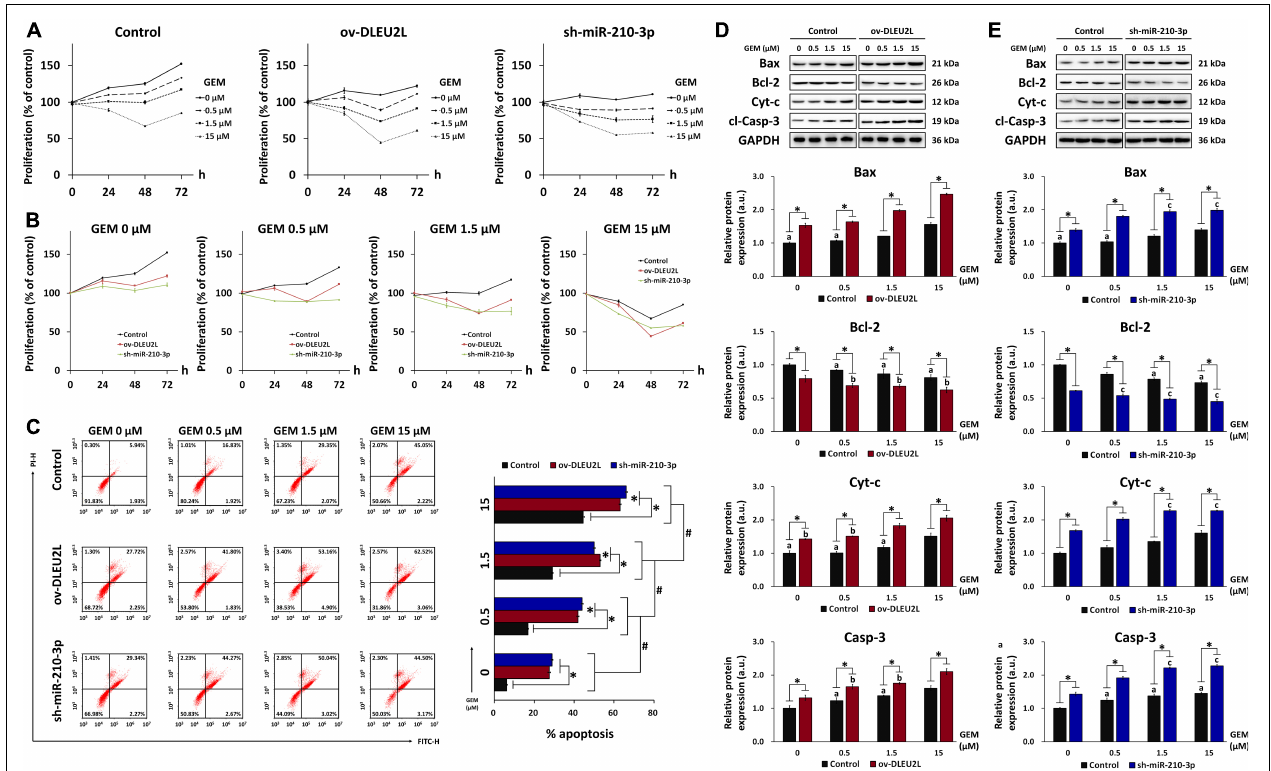
FIGURE 3 | Effect of DLEU2L overexpression and miR-210-3p silencing on PANC-1 cell proliferation and apoptosis in the presence of GEM. MTT assay of PANC-1 cell proliferation plotted based on (A) cell transfection and (B) GEM concentration. For MTT assay, PANC-1 cells were non-transfected (Control) or transfected with DLEU2L overexpression (ov-DLEU2L) or miR-210-3p interference (sh-miR-210-3p) vectors and cultured in the presence of GEM at 0, 0.5, 1.5, or 15 µ M for 0, 24, 48, or 72 h. (C) Flow cytometry of apoptosis and quantification of the percentage of late apoptotic PANC-1 cells (upper right quadrant). Western blot and quantification of the expression of proteins associated with apoptosis (Bax, Bcl-2, Cyt-c, and cl-Casp-3), in PANC-1 cells transfected with (D) DLEU2L overexpression (ov-DLEU2L) or (E) miR-210-3p interference (sh-miR-210-3p) vectors. All numerical data are expressed as the mean ± SD ( n = 3); ∗ p < 0.05; # p < 0.05 within the same group (comparing GEM concentrations); data with the same letters in (D) and (E) are not significantly different ( p > 0.05) in each plot of western blot. Statistical analysis was carried out using